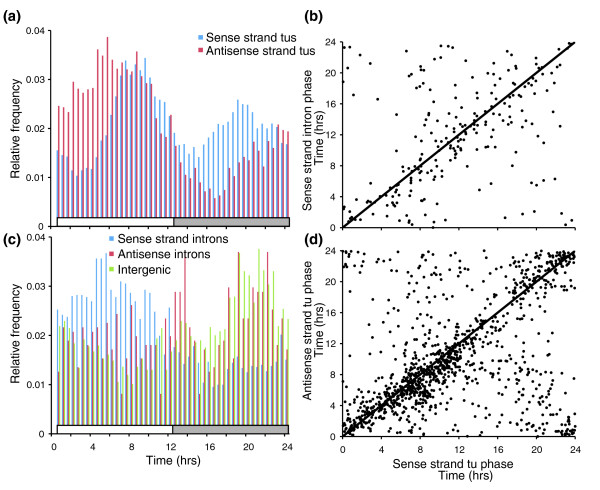
Different types of transcripts and transcription units have variable phase distributions across the day as well as within a locus. (a) Relative phase frequency distribution of cycling sense and antisense transcript phase. (b) Scatter plot of the expression phases of loci with both sense and antisense strand cycling transcripts. (c) Relative phase frequency distribution of cycling sense strand and antisense strand introns and intergenic transcript phase. (d) Scatter plot of the expression phases of transcripts and their cycling introns. tu(s), transcript unit(s).